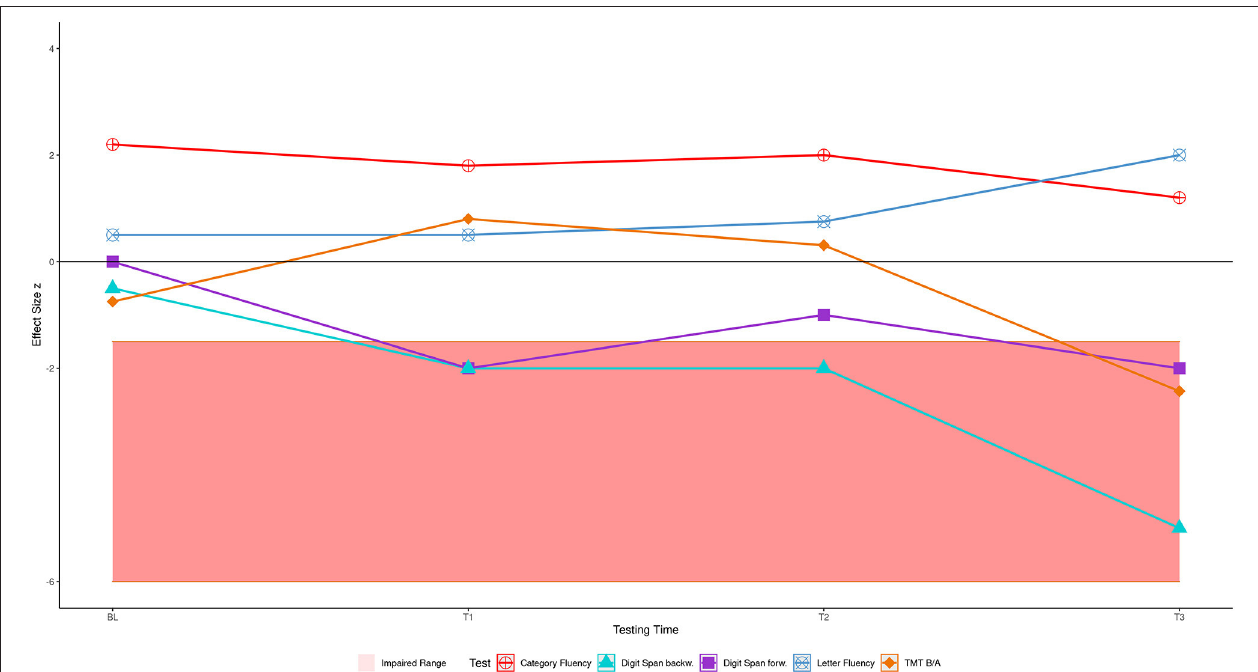
FIGURE 2 | The patient’s cognitive performance over time, shaded area shows impaired range.